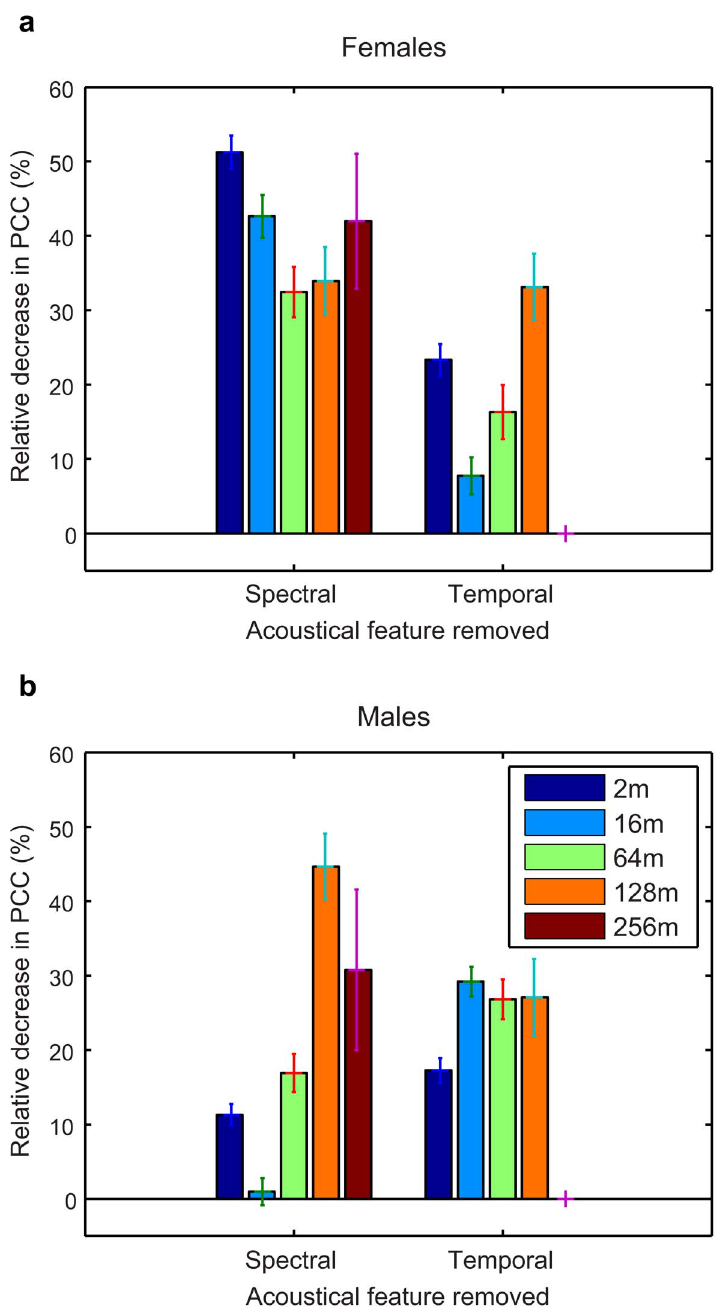
Figure 8. Comparison between the importance of spectral and temporal features of the envelope parameters. Calculations are shown separately for females (a) and males (b). Histograms represent the relative decrease as a percentage in the probability of correct classification (PCC) observed when removing the spectral (left) or temporal (right) parameters from the DFA. Error bars show two-standard errors estimated by bootstrapping. For each distance, except for 128 m for females, the changes observed by removing spectral information vs. the temporal information are significantly different (all p values , 10 2 5 using a two-sided t-test). doi:10.1371/journal.pone.0102842.g008 The results of the discriminant analysis confirm and complete are very different from the spectrographic representation of an average male call, the downsweep component in particular being our knowledge on the sexual dimorphism in the individual signatures of the zebra finch distance call. In males, the faster and absent for short and medium distances and only appearing at more predominant downsweep component appears to become 128 m and 256 m. These fine spectro-temporal modulations critical for discriminability at long distances. Interestingly, while appear therefore less critical for discrimination at short and medium distances. Information about frequency modulation is the DFs for the females are comparable in structure to spectrograms of female calls, the DFs corresponding to the males therefore not necessary at close range. The observation that the